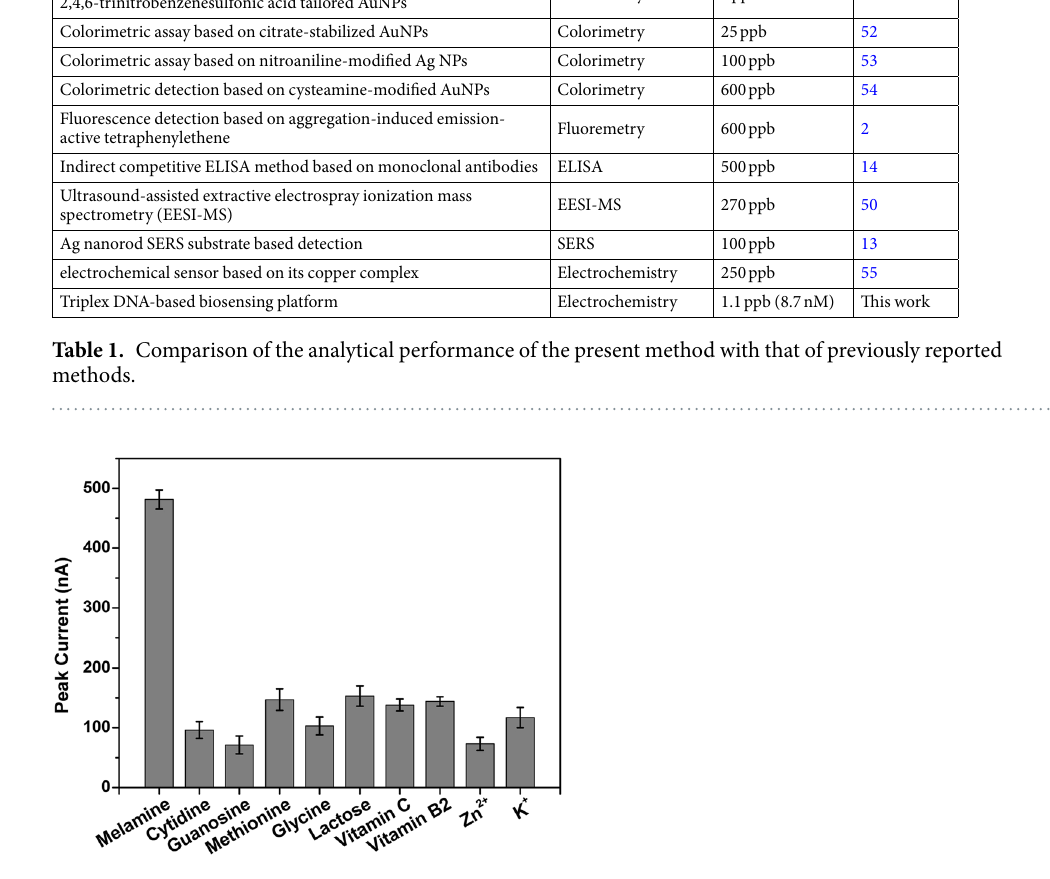
Figure 5. Comparison of DPV peak currents in the presence of melamine, cytidine, guanosine, methionine, glycine, lactose, vitamin C, vitamin B 2 , Zn 2 + , and K + . The concentrations of melamine are 50 μ M and other substances are 100 μΜ . The error bars represent the standard deviation of three